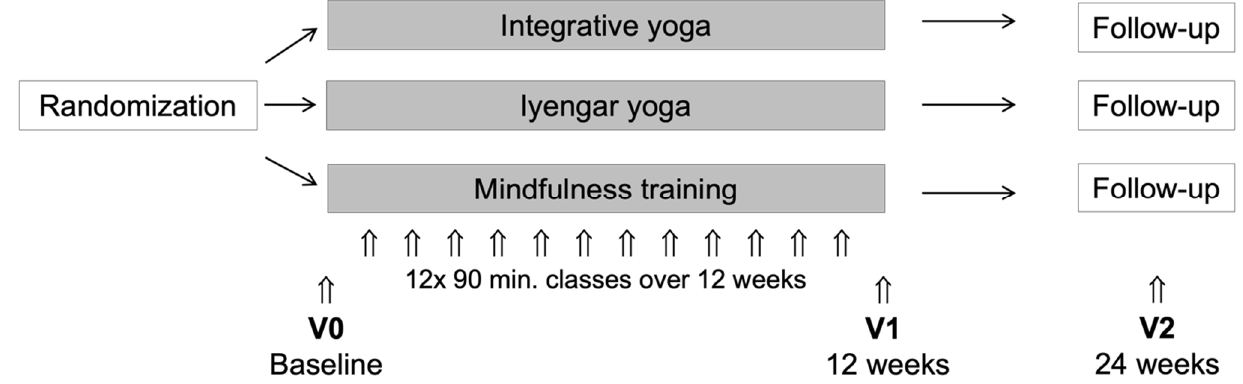
Figure 1. Study structure.